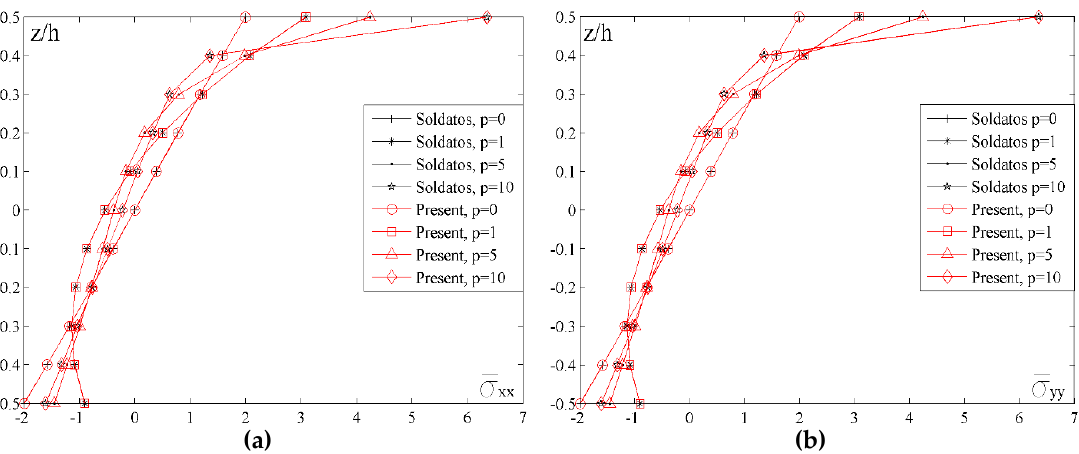
σ and across the yy xx